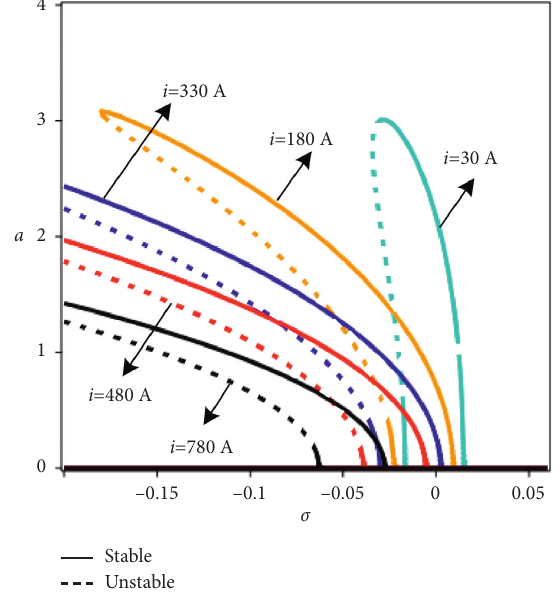
Figure 13: The 1/2-order subharmonic amplitude-frequency re- sponse curve (varied i